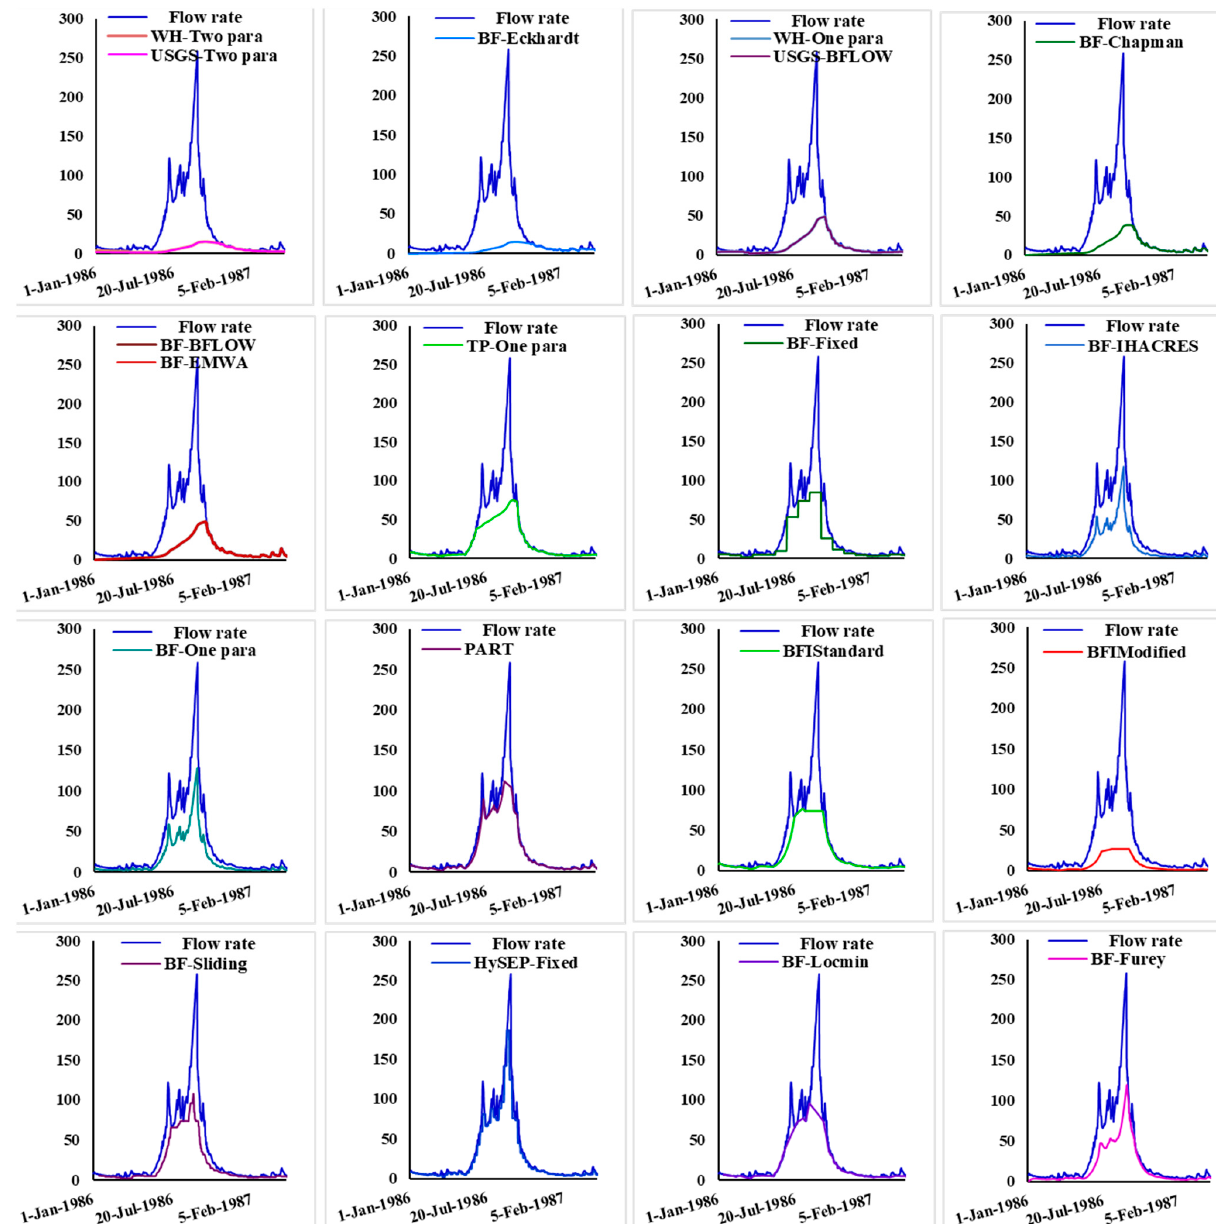
Figure 17. Baseflow separation (one-year) using each automated RDF method for the Gebba stream.